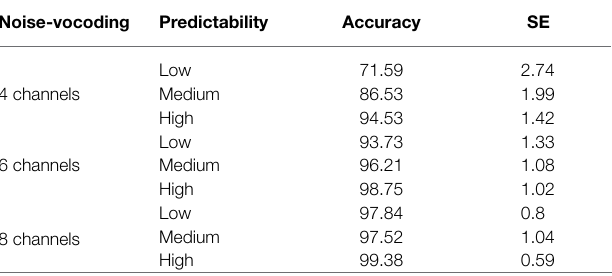
TABLE 4 | Mean response accuracy in predictable channel context.